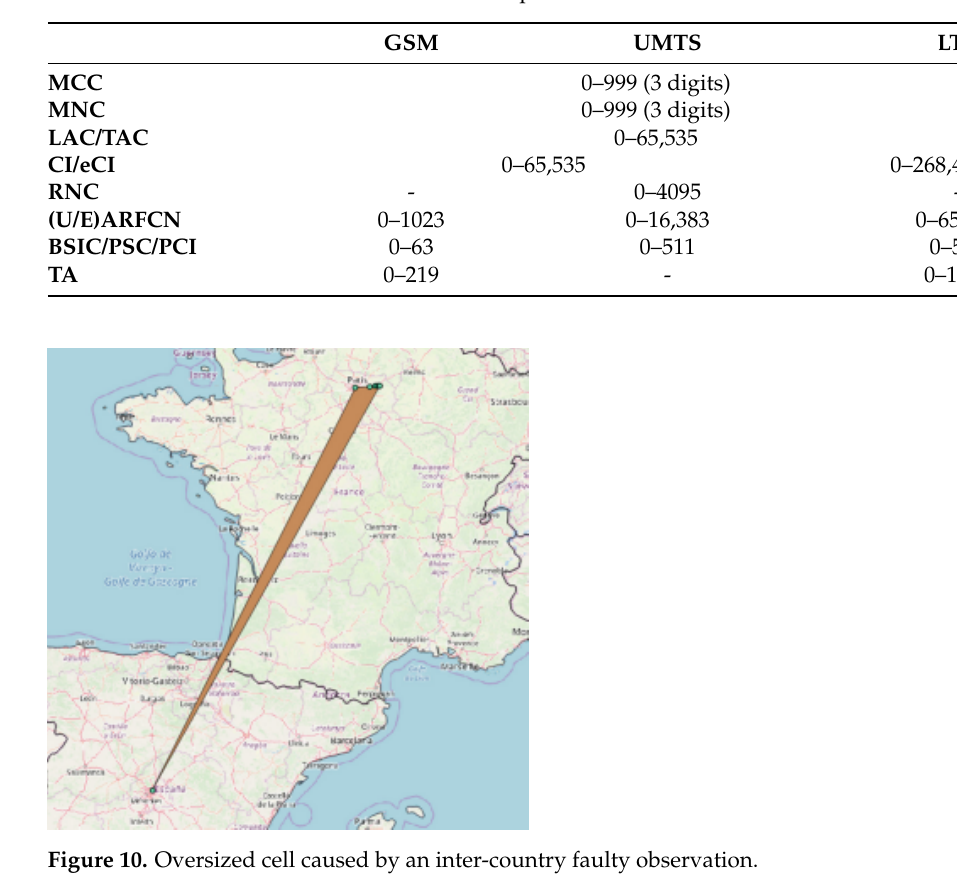
Table 2. Domain constraints on measurement’s parameters.